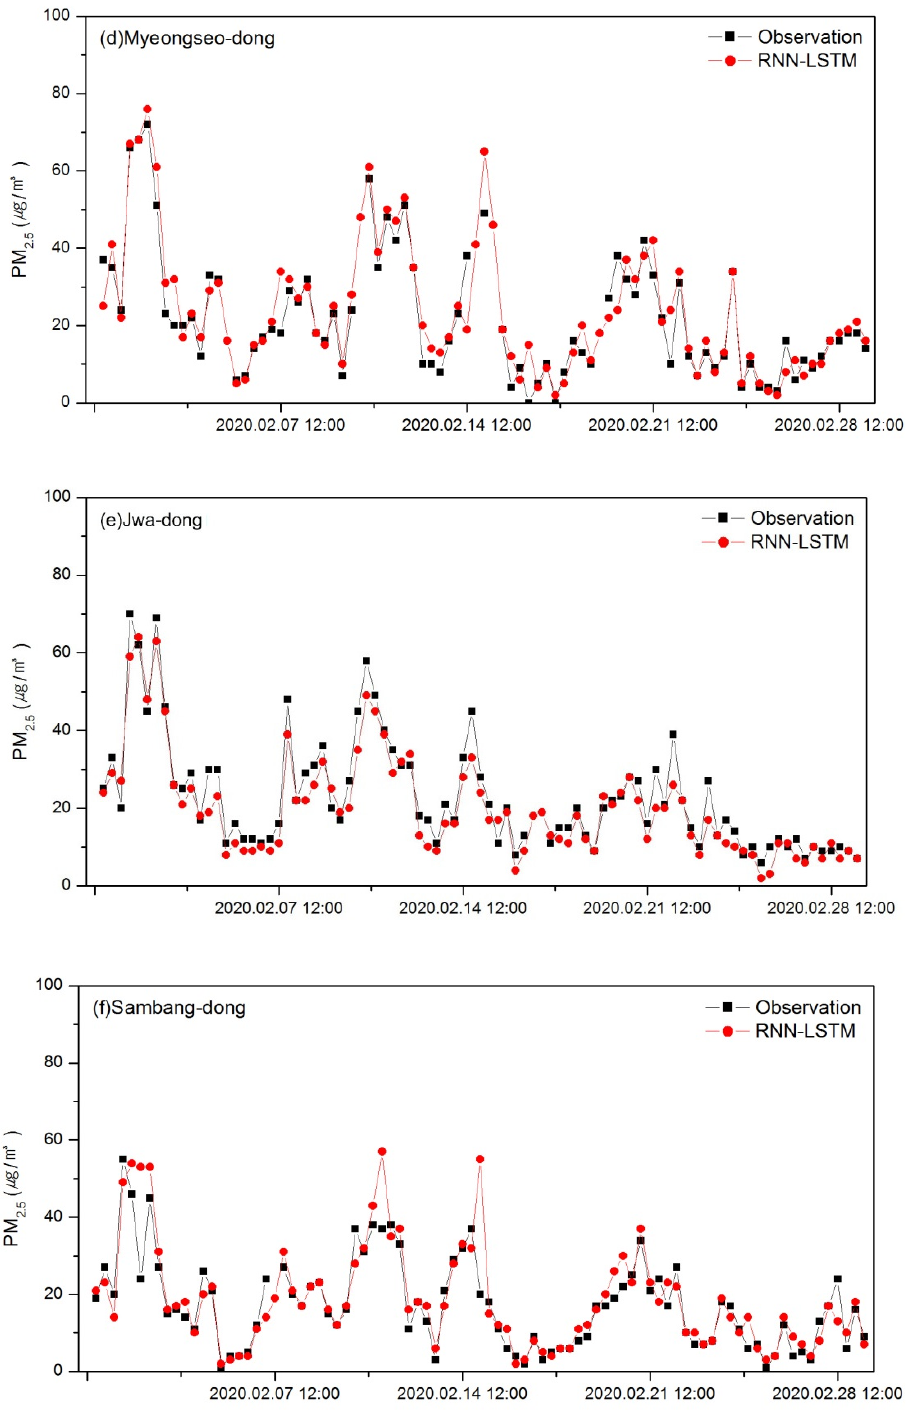
Figure 7. PM 2.5 time series graph for prediction period by site. ( a ) North Port, ( b ) New Port, ( c ) Yongsu-ri, ( d ) Myeongseo-dong, ( e ) Jwa-dong, ( f ) Sambang-dong (time period: 1 February 2020 to